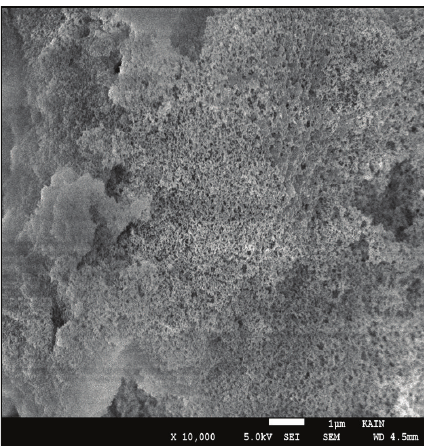
Figure 3: FE-SEM image of PM 597/SiO 2 core/shell NPs.